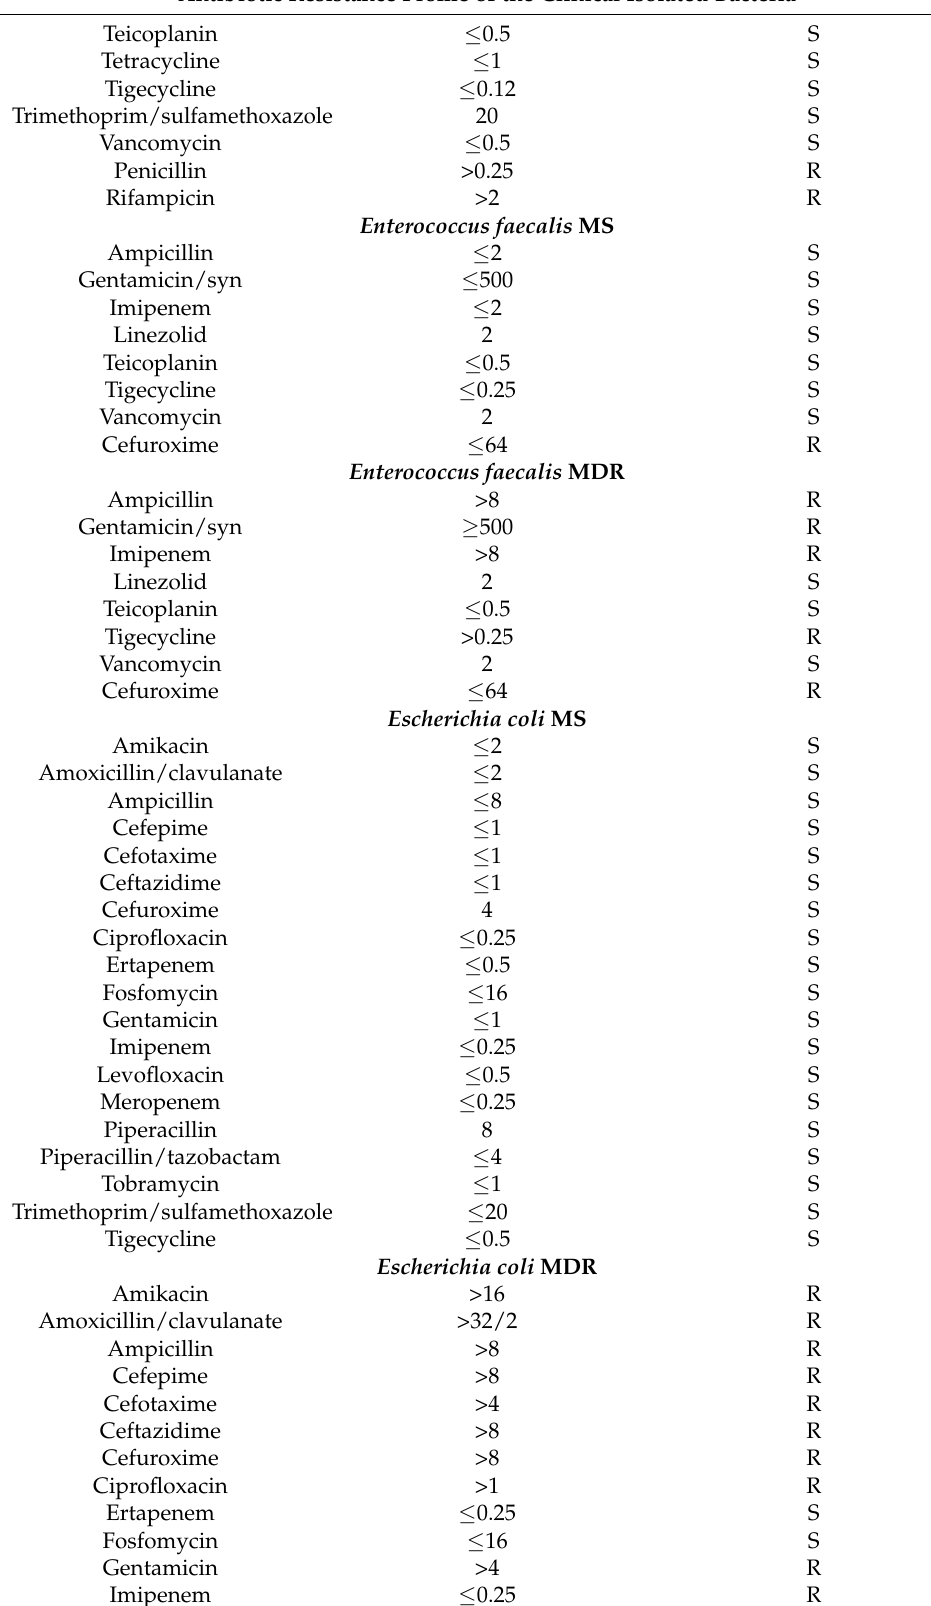
Table 2. Cont. Antibiotic Resistance Profile of the Clinical Isolated